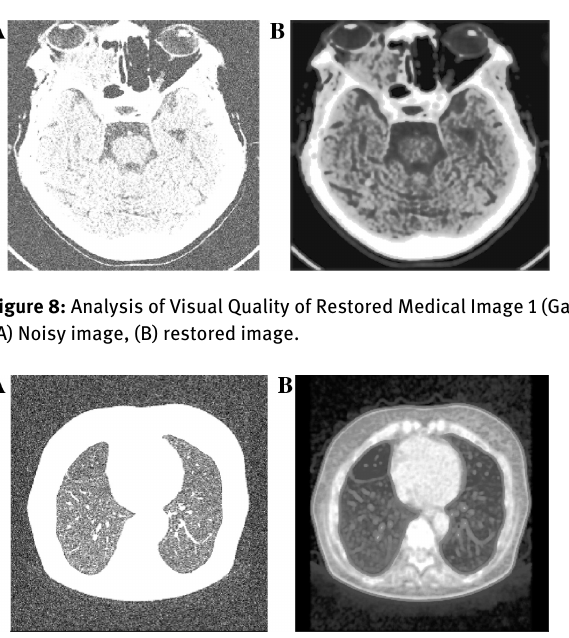
Figure 7: Restored Images Using the LR-SVM-HLOG Method.